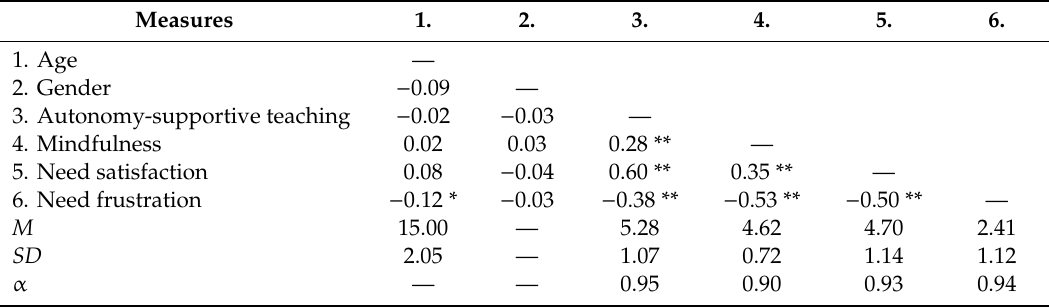
Table 1. Internal reliability and descriptive statistics for the study variables.